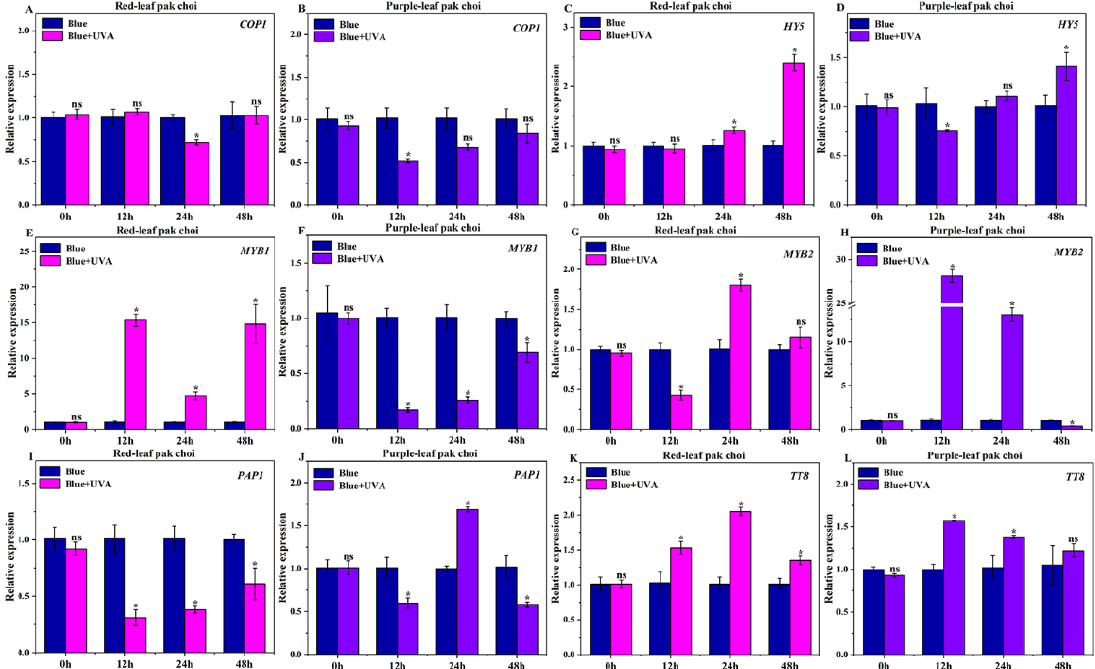
Figure 8 . qRT-PCR analysis results of anthocyanin regulatory genes in red- and purple-leaf pak choi. These genes were abbreviated as follows: constitutively photomorphogenic 1 ( COP1 ) of red- ( A ) and purple-leaf ( B ) pak choi; elongated hypocotyl5 ( HY5 ) of red- ( C ) and purple-leaf ( D ) pak choi; MYB domain protein 1 ( MYB1 ) of red- ( E ) and purple-leaf ( F ) pak choi; MYB domain protein 2 ( MYB2 ) of red- ( G ) and purple-leaf ( H ) pak choi; production of anthocyanin pigment 1 ( PAP1 ) in red- ( I ) and purple- leaf ( J ) pak choi; transparent testa 8 ( TT8 ) of red- ( K ) and purple-leaf ( L ) pak choi. Detection of quantitative RT-PCR analysis at four time points under blue and blue + UVA light continuous illumination for 48 h. ‘ns’ means non-significant and ‘*’ represents statistically significant differences ( p < 0.05). Error bars indicate ± SE ( n = 3).